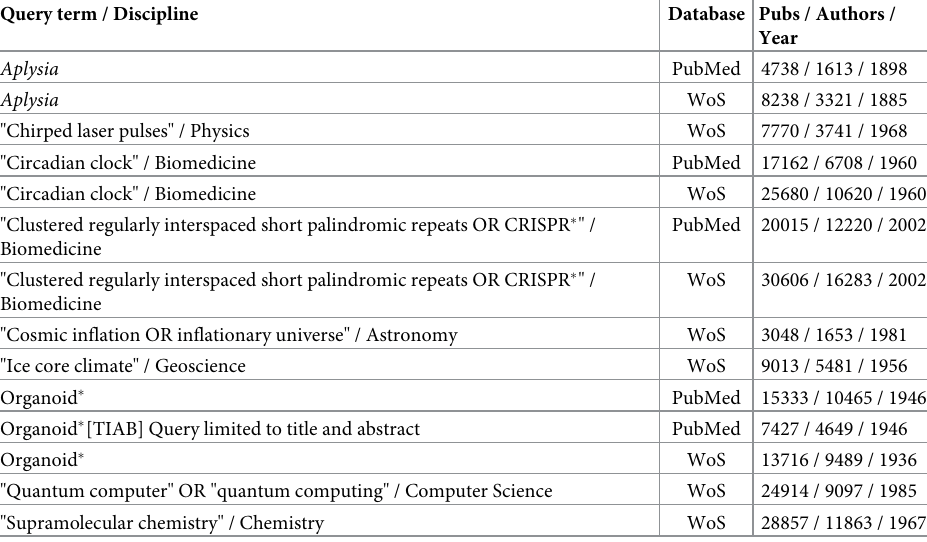
Table 2. Selected research fields subjected to